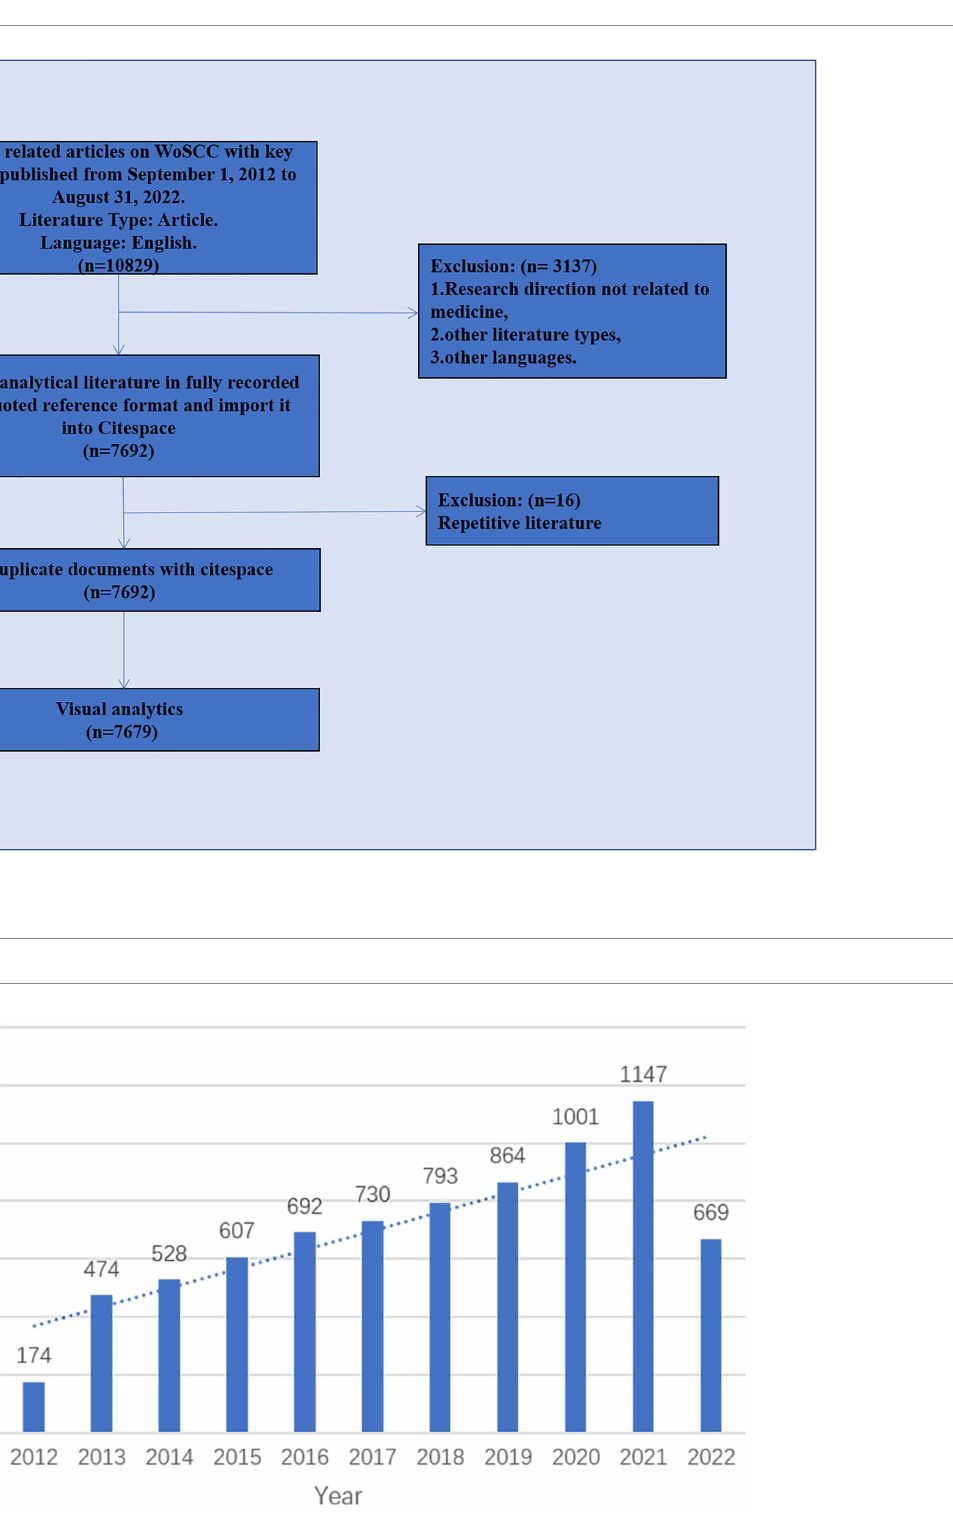
FIGURE 2 Distribution of annual